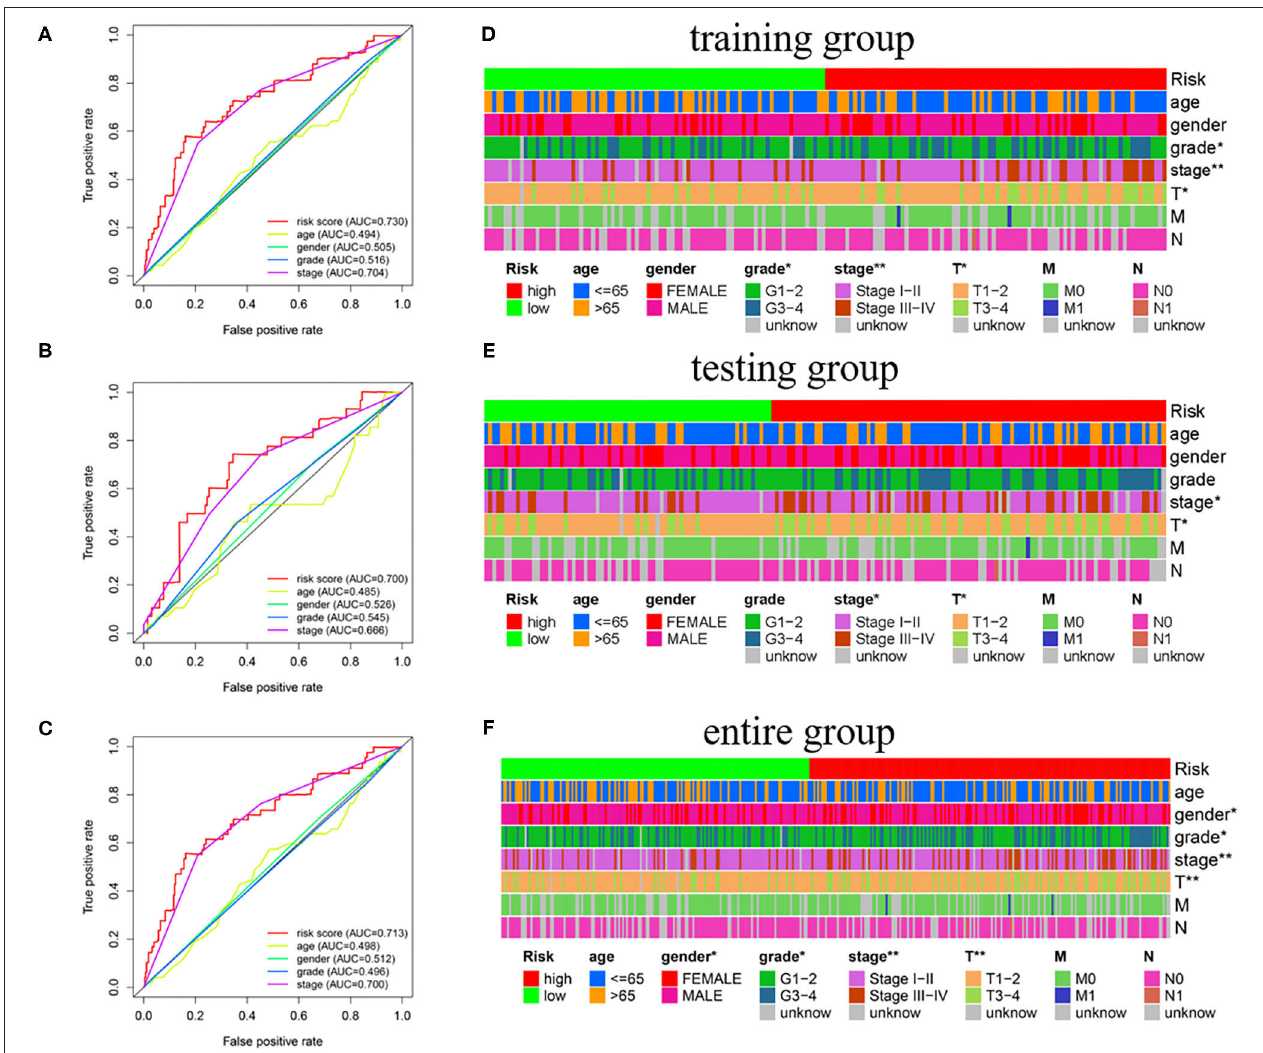
FIGURE 5 | The association of GILncSig and clinical features. (A – C) ROC curve analysis of the training group, the testing group, and the entire group. (D – F) Differential analysis between GILncSig and clinicopathological features. * p < 0.05; ** p < 0.01.